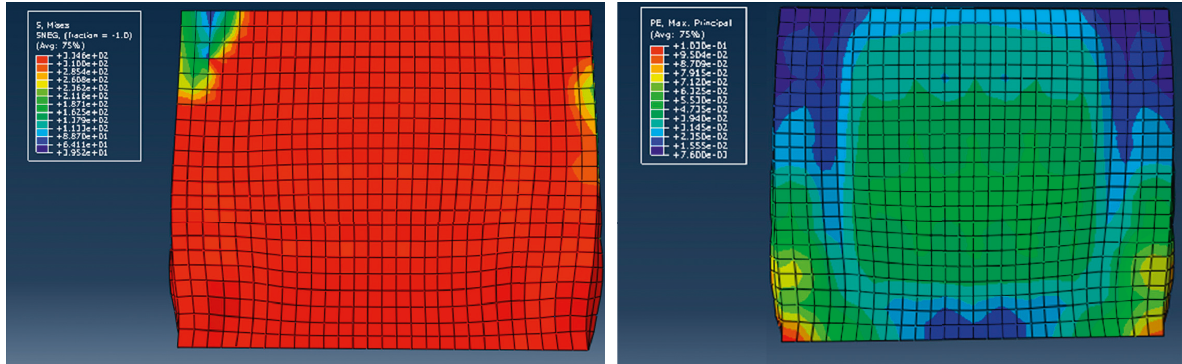
Figure 15: Stress and strain in composite walls.